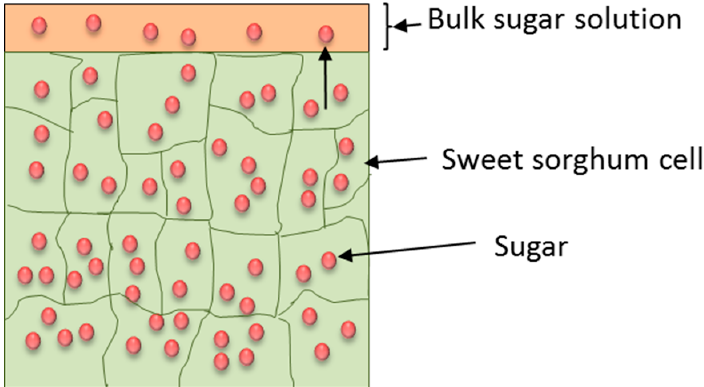
Figure 2. A schematic diagram of the structure of sweet sorghum indicating the transfer of sugar from the interior cell plant cell into the bulk